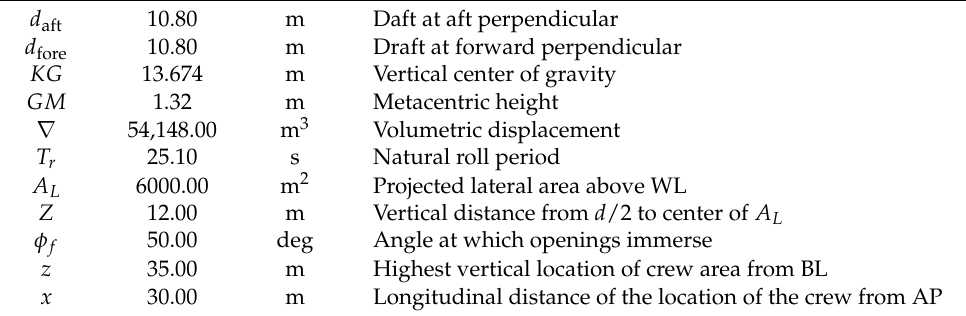
Table 24. Loading conditions of KCS container ship.